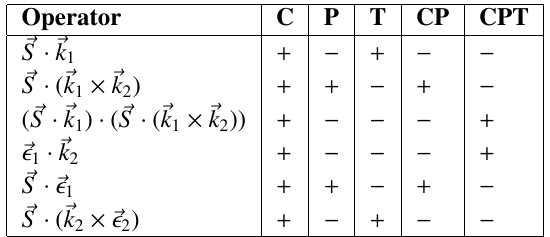
Table 1. Discrete symmetry odd-operators using spin orientation of the o-Ps, polarization and momentum directions of the annihilation photons.